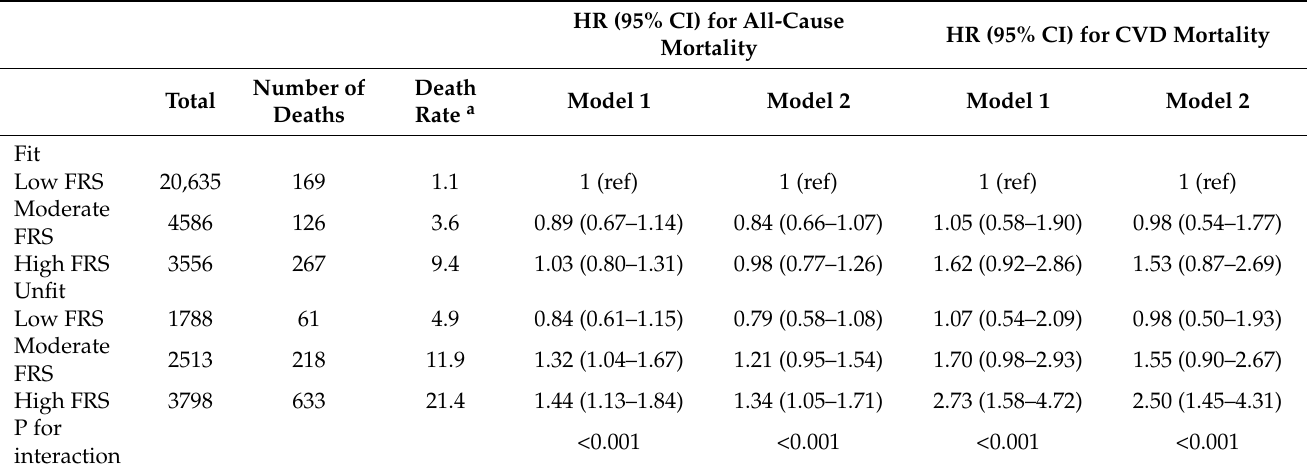
Table 4. The combined associations of estimated cardiorespiratory fitness (eCRF) and 10-year Fram- ingham risk score (FRS) with all-cause and cardiovascular disease (CVD) mortality. HR (95% CI) for All-Cause